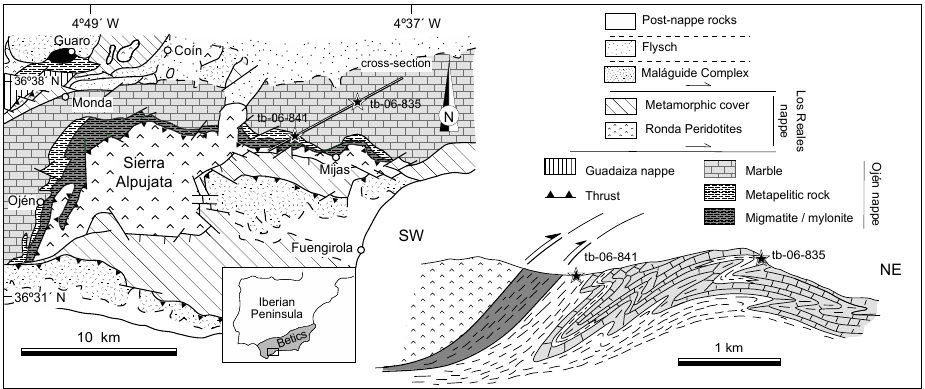
Figure 1. Geological map and cross-section of the Ojén nappe (taken from [16]) with studied sample (tb-06-841 and tb-06-835) locations (stars).